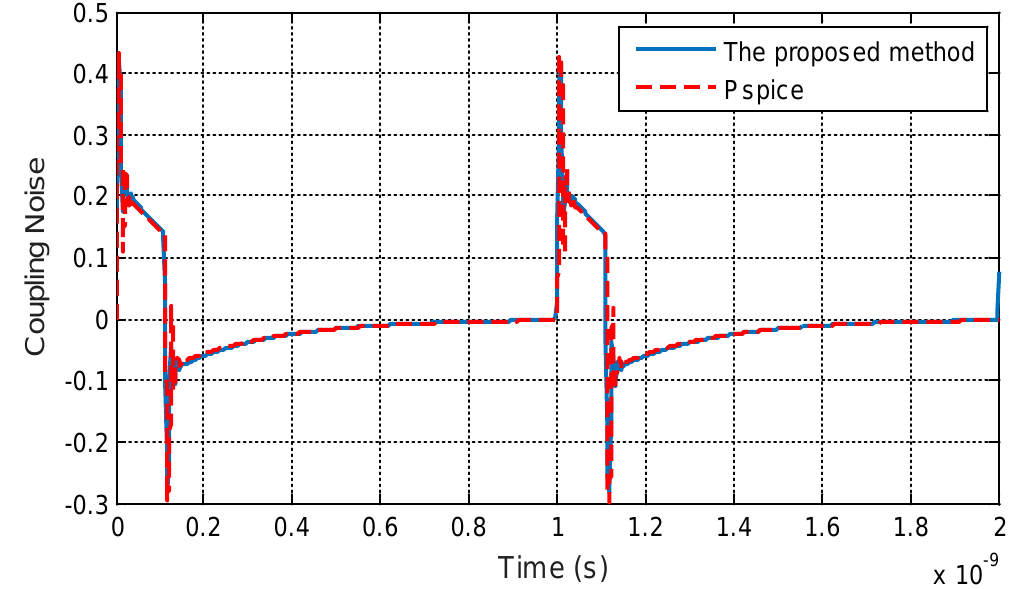
Figure 17. The proposed method and Pspice simulation of the TSV – TSV coupling noise with coupled RDLs ( l RDL = 200 µm and t r = 10 ps) at port 4.